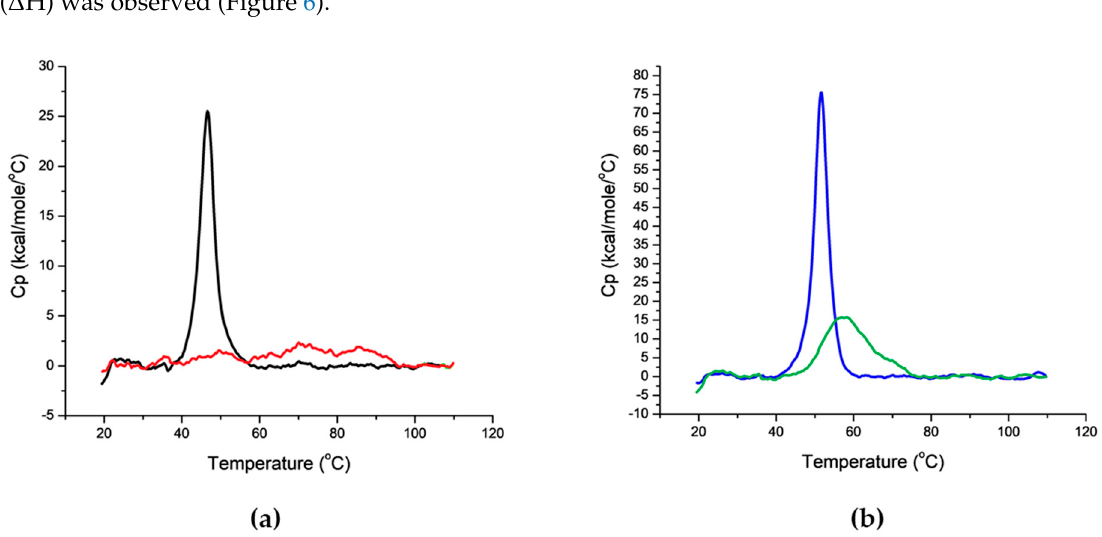
Figure 6. Differential Scanning Calorimetry (DSC) thermograms of ( a ) unconjugated SLO vs GACox-SLO and ( b ) unconjugated SpyAD vs GACox-SpyAD. GAS proteins and corresponding conjugates were analyzed in phosphate buffer at pH 7.2, at the same molar concentration of 3 µM for SLO and 2 µM for SpyAD. The ∆ H value (from the integrated areas under the curves) for each thermogram was: 1.3 × 10 5 kcal/mole (SLO, black line); nd (GACox-SLO, red line); 3.7 × 10 5 kcal/mole (SpyAD, blue line); 2.4 × 10 5 kcal/mole (GACox-SpyAD, green line).